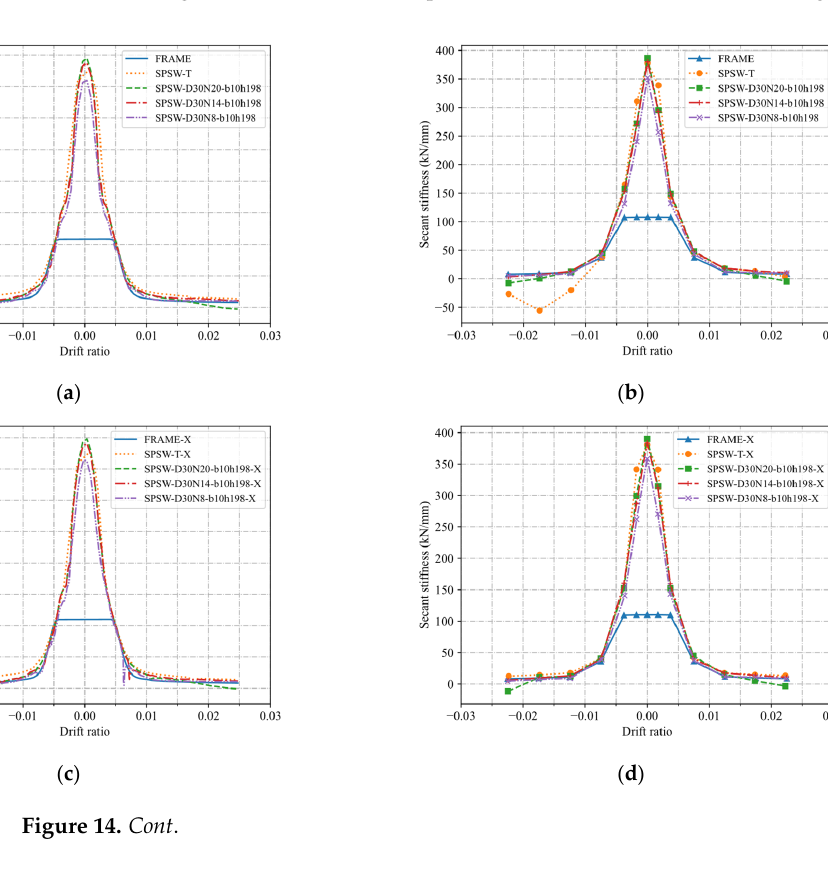
Figure 13. Comparison between the pushover and envelope curves of different models with and without frame beam flange constraints: ( a ) pushover curves (models without frame beam flange constraints); ( b ) envelope curves (models without frame beam flange constraints); ( c ) pushover curves (models with frame beam flange constraints); ( d ) envelope curves (models with frame beam flange constraints).